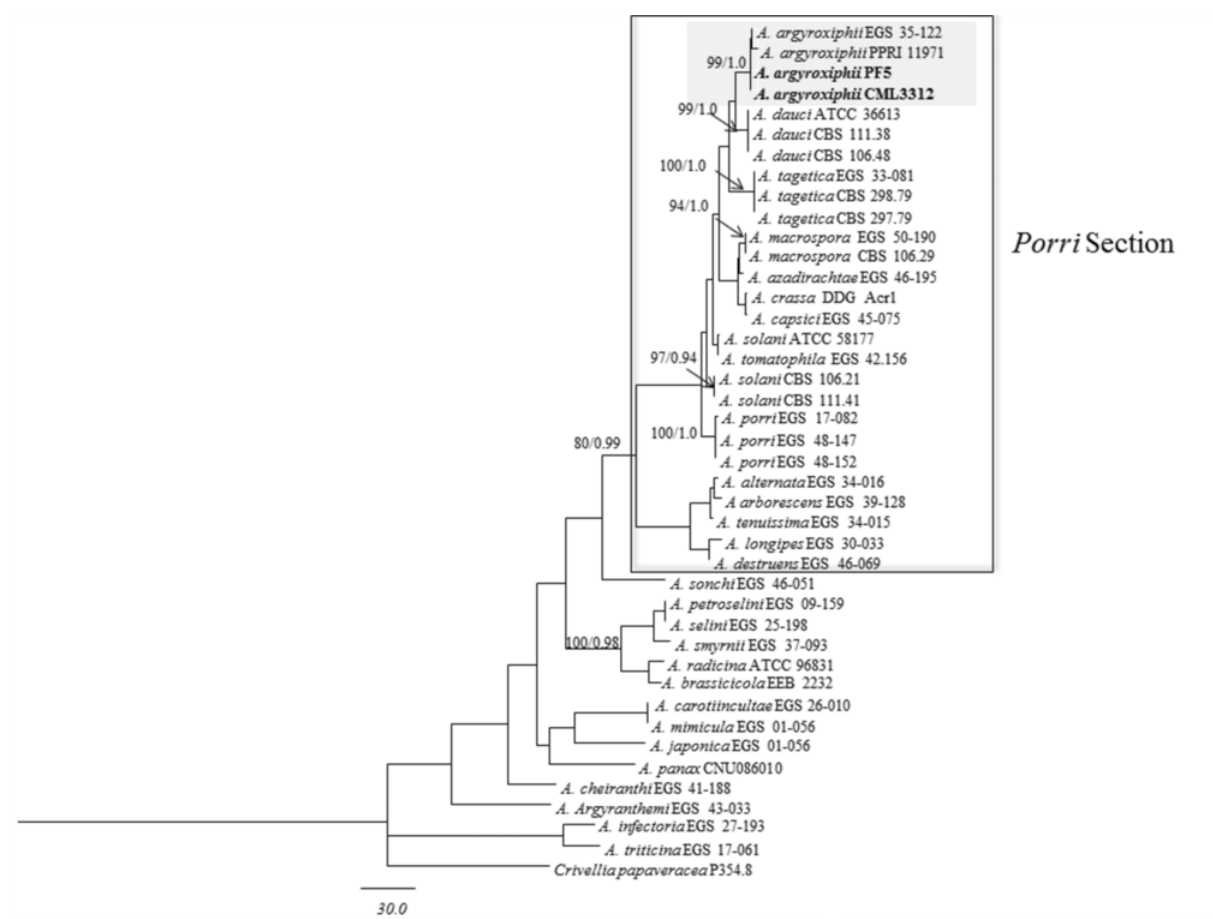
Figure 3. Most parsimonious tree based on the combined dataset of the two sequenced regions ( gpd , and Alt a1 ) of Alter- naria spp. Isolates in bold with gray background were isolated from Khaya senegalensis and sequenced in the present study. Bootstrap values greater than 70%, posterior probability values greater than 80% are indicated above the branches. Crivellia papaveraceae was used as an outgroup taxon. Scale bar indicates expected changes per